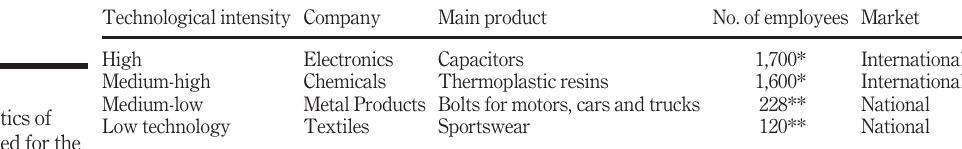
Table III. Characteristics of fi rms selected for the